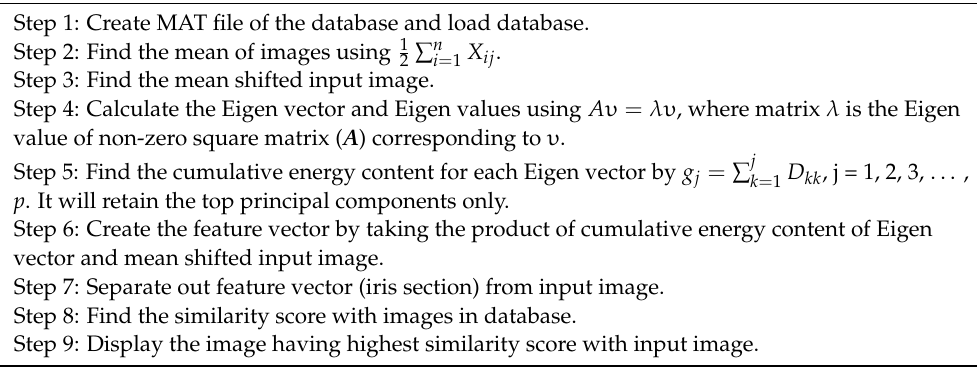
Algorithm 4: Principal Component Analysis (PCA).